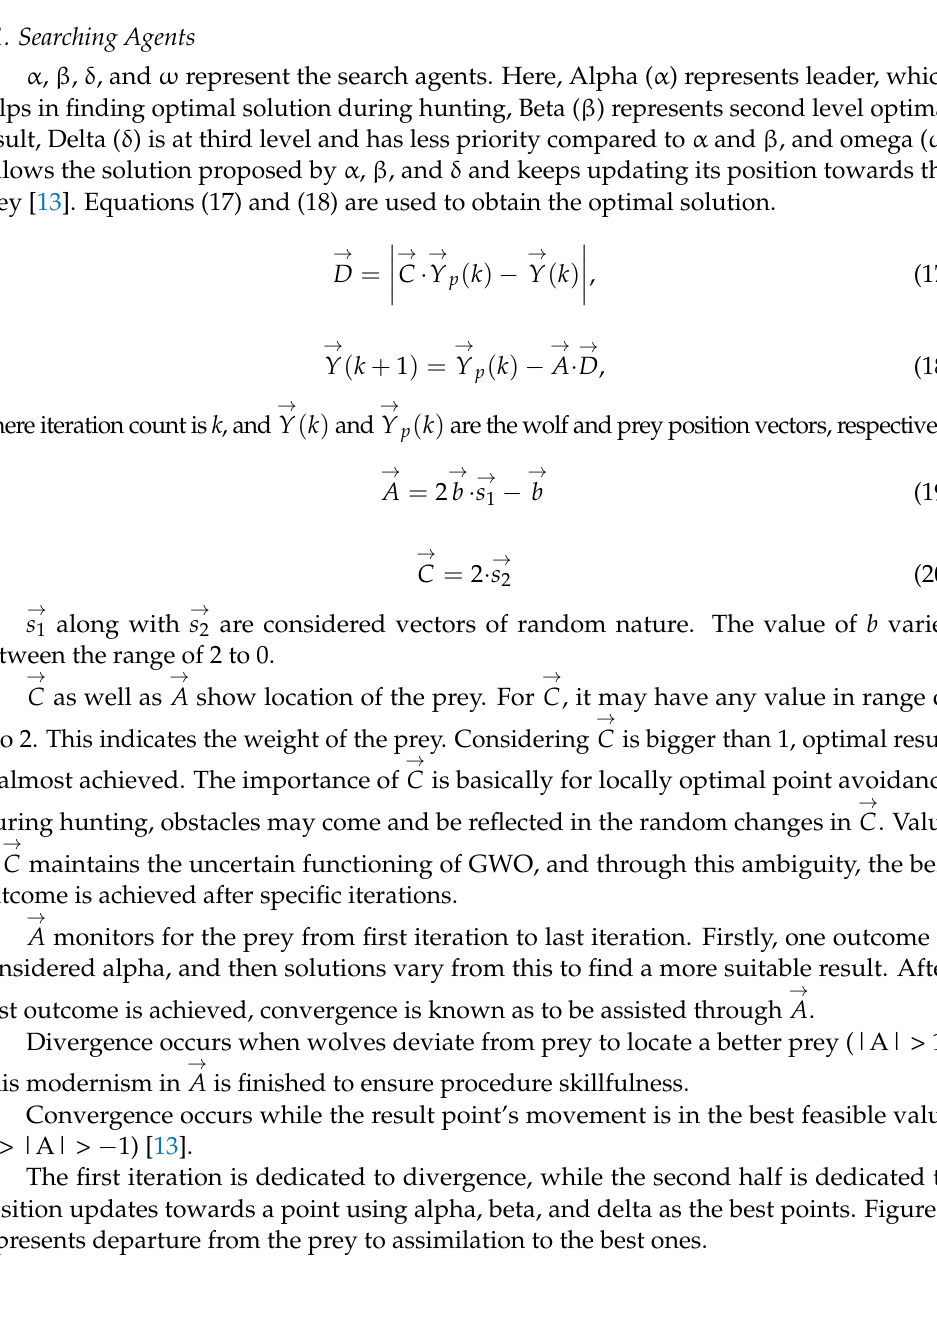
Table 2. Hierarchy level of wolfs (in hunting process). Hierarchy Rank Roles 1 α Main authority, imposes a choice on the pack Counselor to Alfa, keep the pack